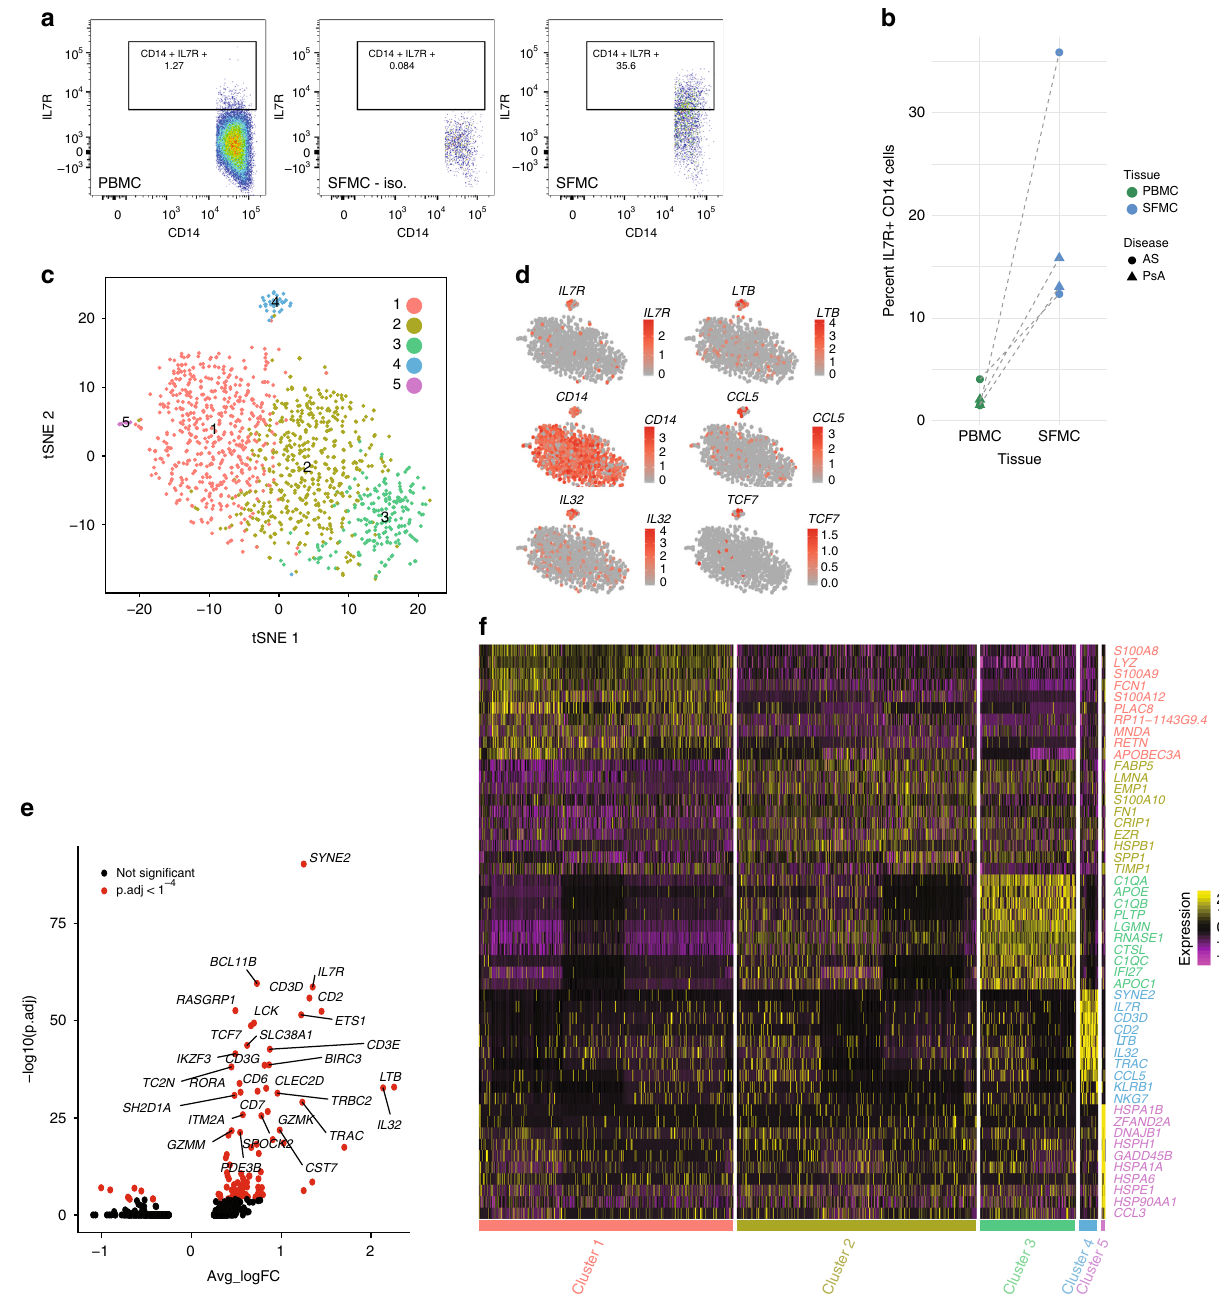
Fig. 5 IL7R + monocytes form a distinct subset detectable in synovial fl uid. a Representative fl ow cytometry of IL7R staining of spondyloarthritis matched patient PBMC (left) and SFMC (middle isotype control, right) gated on CD3 - CD14 + as per sequential gating strategy shown in Supplementary Fig. 1. b Results from 4 patients demonstrating comparative monocyte IL7R staining in matched PBMC and SFMC using fl ow cytometry. c t-SNE clustering of monocytes from single-cell RNA sequencing of spondyloarthritis patient SFMC showing 5 clusters ( n = 3). d Single-cell monocyte expression of IL7R, LTB, CD14, CCL5, IL32 , and TCF7 overlaid on t-SNE clustering in c . e Volcano plot of genes signi fi cantly upregulated in the SFMC monocyte cluster 4 compared to all other SFMC monocyte clusters with top 20 genes annotated. Wilcoxon rank sum test. f Heatmap of top 10 genes from the each of the fi ve SFMC monocyte clusters identi fi ed in